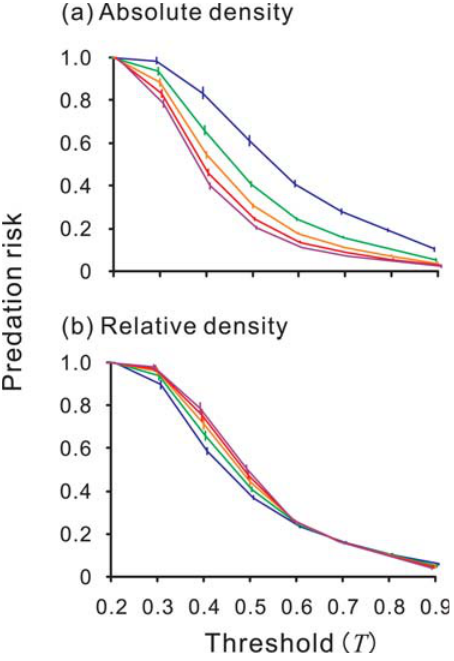
Figure 3. The effect of (a) absolute and (b) relative density of the Model on its predation risk. Each point and error bar represent the mean and standard deviation of the replications. D mi =0.1 (blue), 0.2 (green), 0.3 (orenge), 0.4 (red), or 0.5 (purple). (a) The density of both the Mimic and the Model is varied between 0.1 and 0.5 while keeping their ratio constant at 1.0. (b) The density of the Model is held constant at 0.2, while the density of the Mimic is varied between 0.1 and 0.5. X mo =0.2, X mi =0.8, a =0.5, w =0.02. Notice that the risk of predation on the Model (and the Mimic) is influenced more by absolute density ( D mo ) than by relative density ( D mo / D mi ) of the Model.